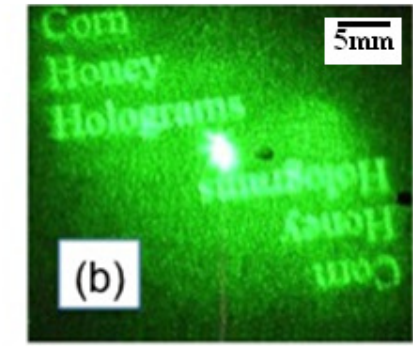
Figure 3. Optical reconstruction of Fourier binary holograms in a corn syrup film ( a ) INAOE logo; ( b ) Hologram of the phrase “corn honey holograms”. The diffracted image of the hologram has a physical size of approximately 3 cm × 3